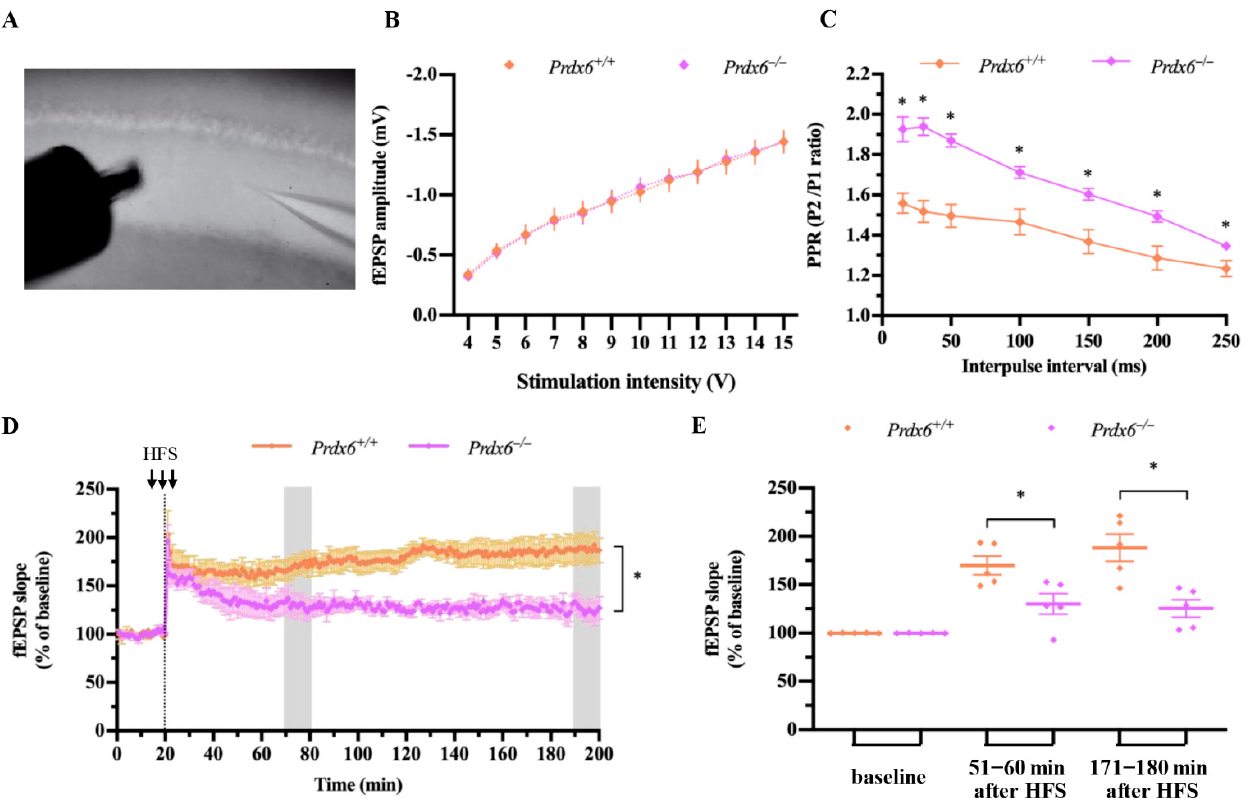
Figure 6. Impaired hippocampal LTP in female Prdx6 − / − mice. ( A ) Representative image for the positions of stimulus and recording electrodes in the hippocampal CA1 region. ( B ) Input–Output curve for fFPSP amplitudes ( n = 8 slices/ 5 mice in each group). ( C ) the paired–pulse facilitation (PPF) ratio, delivered throughout the five selected interstimulus intervals (50, 100, 150, 200, and 250 ms) ( n = 8 slices/ 5 mice in Prdx6 +/+ group and n = 9 slices/ 5 mice in Prdx6 − / − mice). ( D ) The averaged fEPSP traces of Prdx6 +/+ and Prdx6 − / − mice ( n = 5 mice/group). The gray boxes represent the regions of the last 10 min of the first and third hours. ( E ) The averages of the percentage of normalized fEPSP slopes from the last 10 min of the first and third hours. All data are presented as mean ± SEM., * p < 0.05, mixed-design repeated measure ANOVA followed by Bonferroni 's post hoc test with unpaired Student's t -test for individual differences between groups within each time point. fEPSP, field excitatory postsynaptic potential; PRDX6, peroxiredoxin 6; PPR, paired-pulse ratio; HFS, high frequency stimulation.